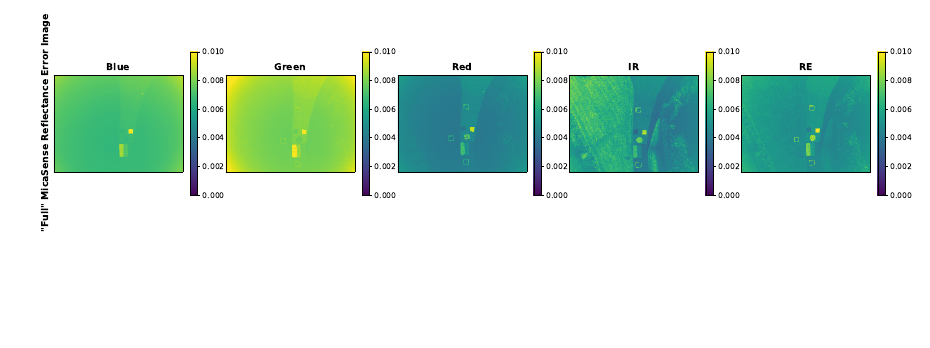
Figure 29. Example sUAS reflectance error image. Error image contains the measured gain, exposure time, image and dls error. While the vignette and radiometric calibration coefficient standard errors were set to 1% of their values. These error images produce the same features as the reflectance image and the proposed methodology reflectance error images. Reflectance factor is a unit-less